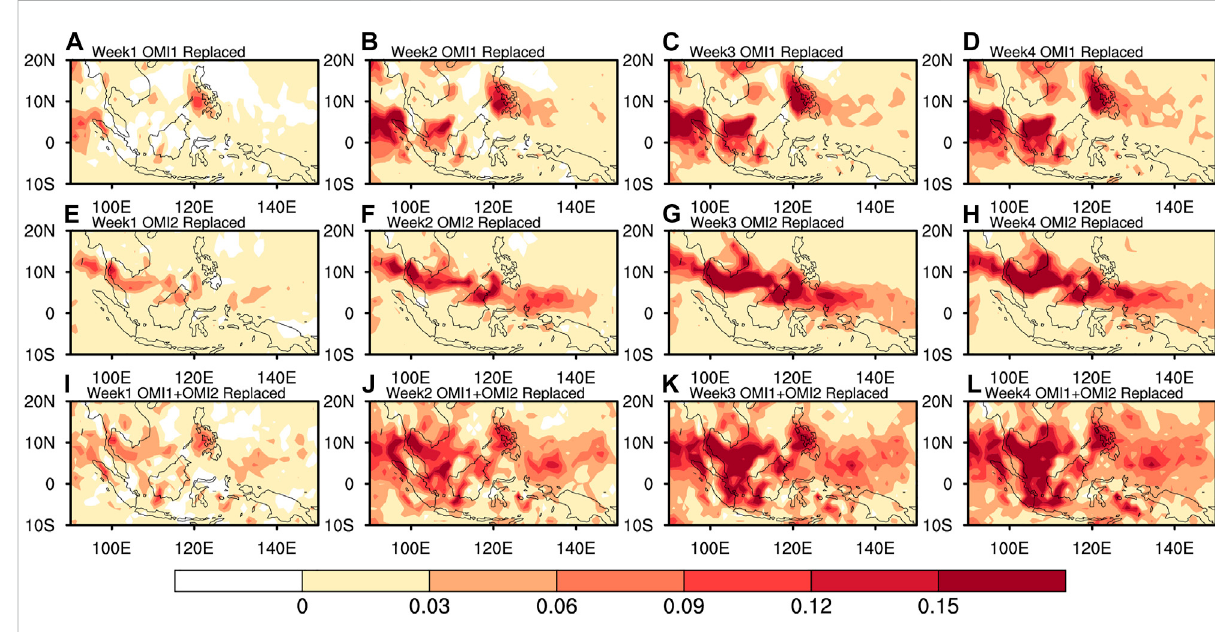
FIGURE 8 Spatial distributions of enhanced correlations between hindcasts and observed precipitation anomalies at lead times of 1 – 4 weeks after replacing the modeled regression patterns associated with drivers of OMI1 (A – D) , OMI2 (E – H) , and OMI1+OMI2 (I – L) with the observed regression patterns for the CMA